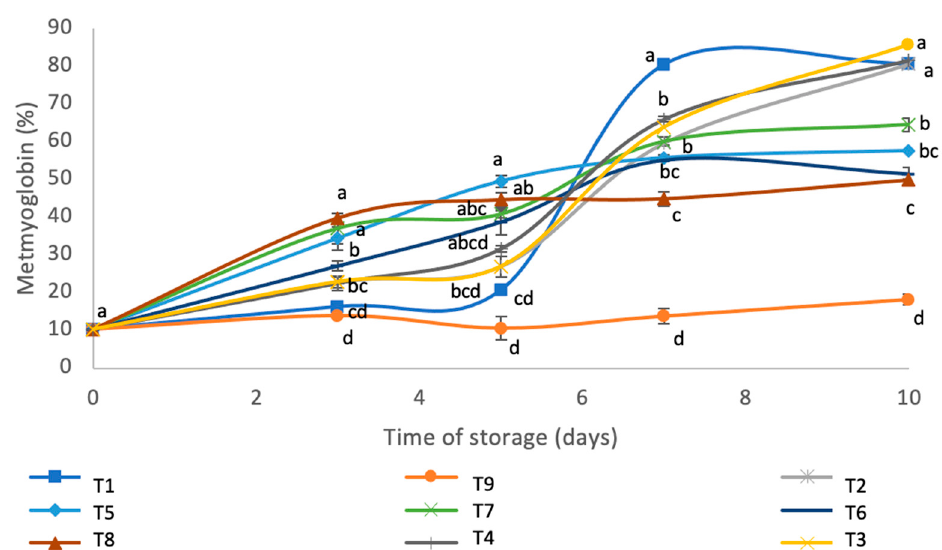
Figure 2. The % of metmyoglobin in beef patties during 12 days of refrigerated storage at 4 ± 1 ◦ C. Di ff erent letters across the same day indicate significant di ff erences between samples. T1: CM (control), T2: 2% PSW, T3: 4% PSW, T4: 0.35% CA, T5: 2% RS, T6: 2% PSW + 0.35% CA, T7: 2% PSW + 0.35% CA + 2% RS, T8: 4% PSW + 0.35% CA + 2% RS and T9: 0.7% CAMPA N.3 (A).